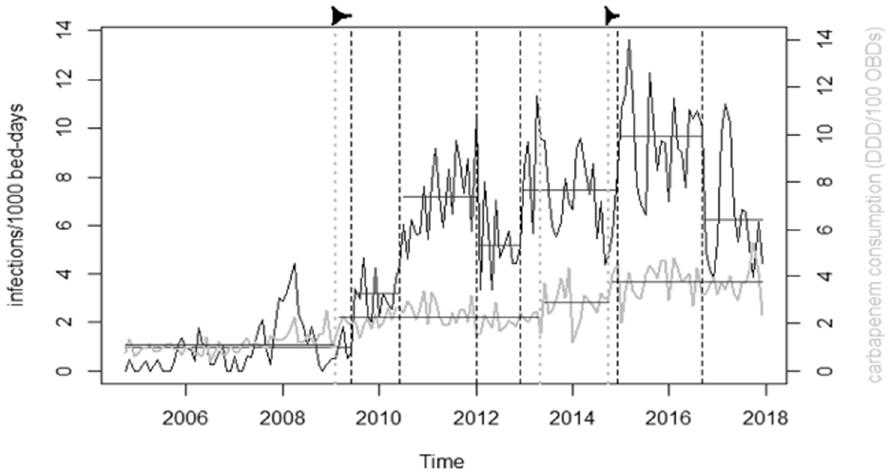
Figure 4. Results of the changepoint analysis. Grey line shows carbapenem consumption, black line shows incidence density of infections by CRAb . Dashed vertical lines mark the changepoints found, horizontal lines mark averages of sections of the time-series between changepoints. The two arrows mark the correspondences between changepoints in carbapenem consumption and incidence.